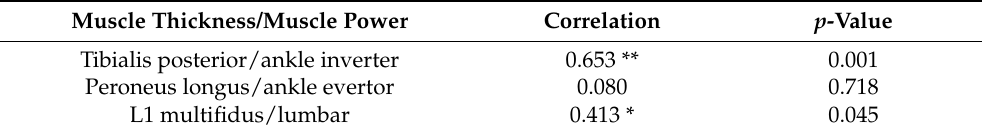
Table 5. Correlation between muscle strength and muscle thickness for male participants (n = 12).